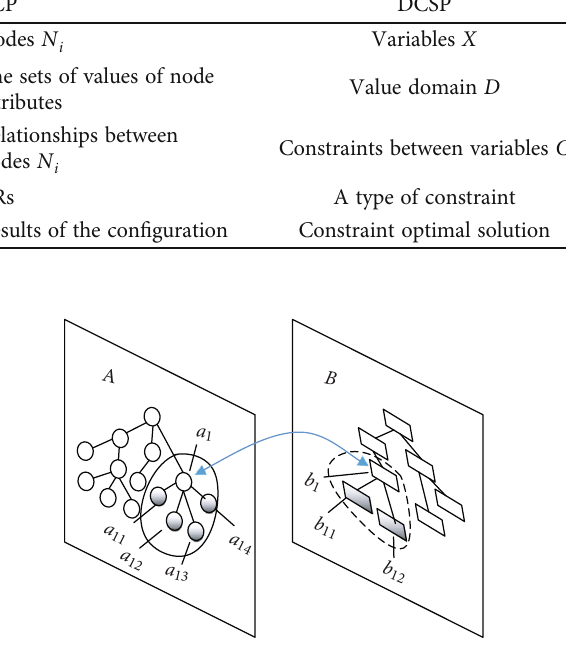
Figure 3: Hierarchical constraints between complex variables.